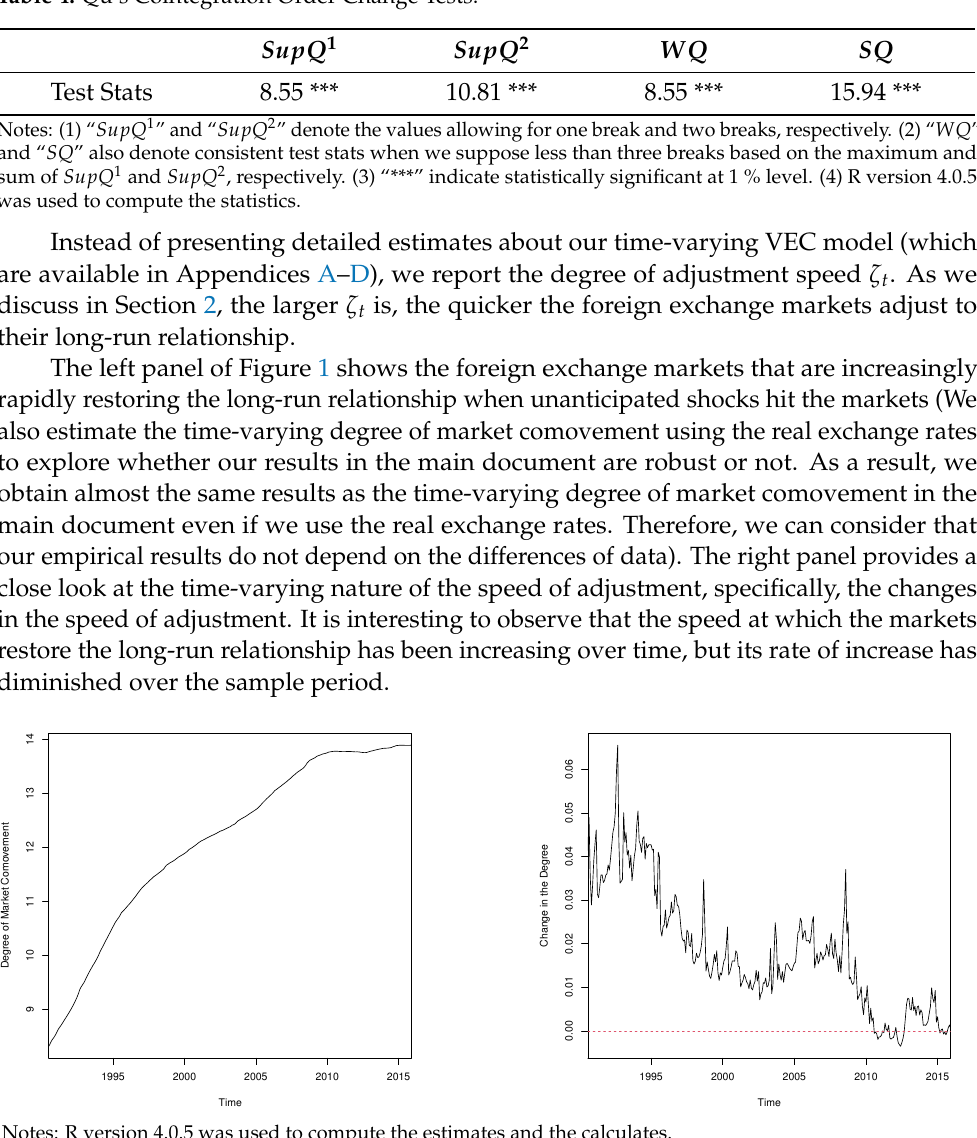
Figure 1. Time-Varying Degree of Market